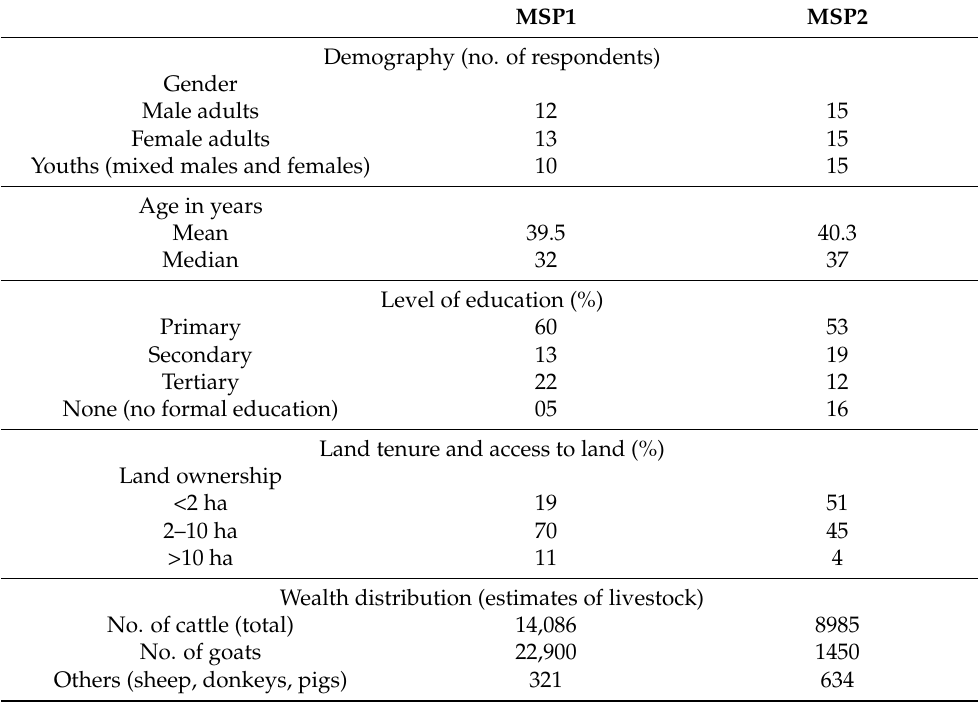
Table 1. Demographic details of participants in MSPs.